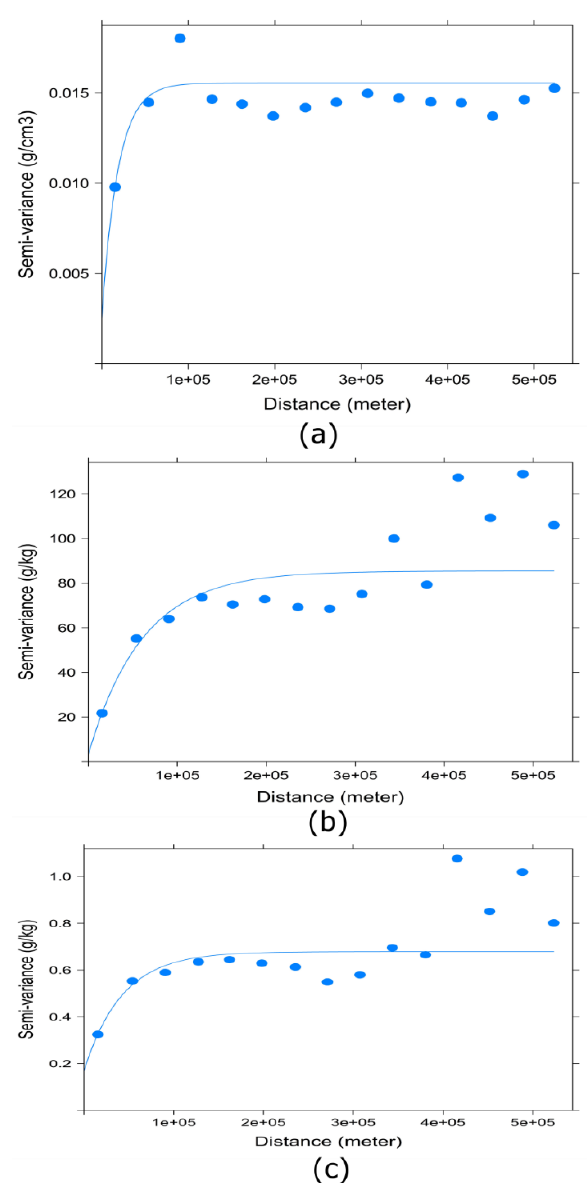
Figure 6. Variogram for ( a ) bulk density, ( b ) total nitrogen, and ( c ) organic matter. The solid blue line represents the exponential covariance function model fitted in the variogram.